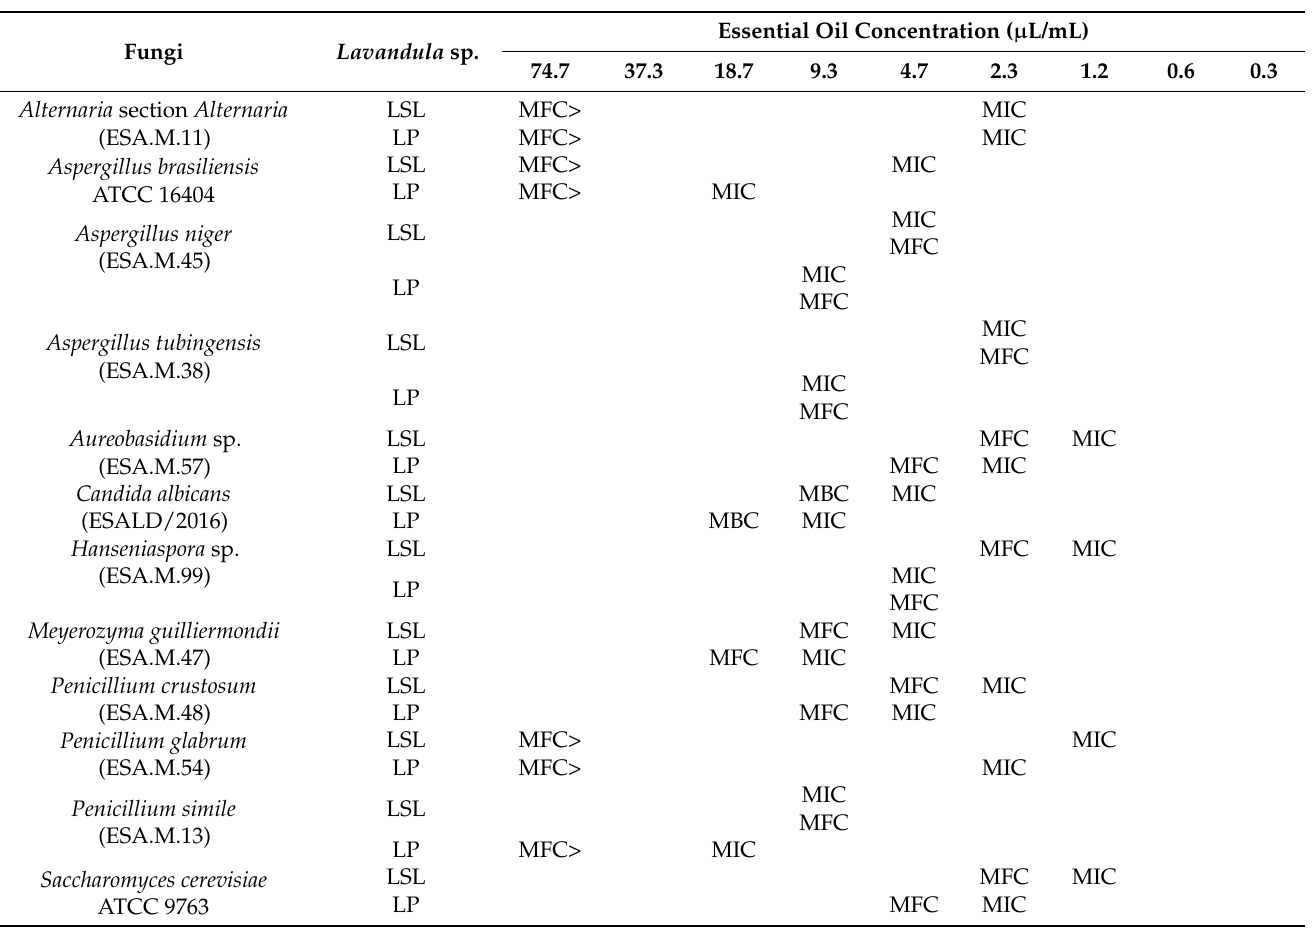
Table 3. Minimum inhibitory concentration (MIC) and minimum fungicidal concentration (MFC)